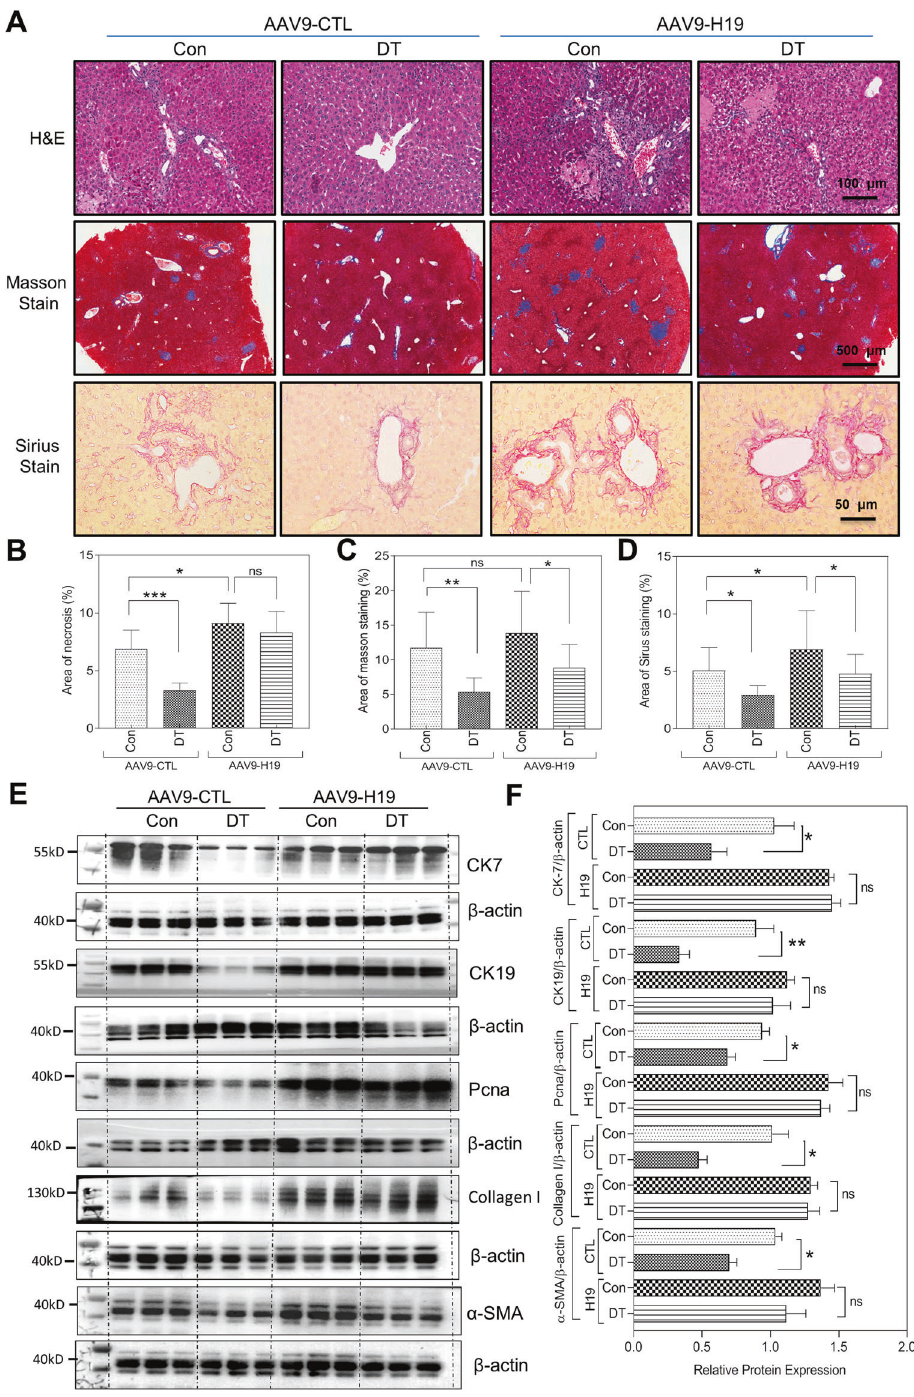
Fig. 5 H19 overexpression in the liver counteracts the macrophage depletion-mediated protective effect on cholestatic liver fi brosis and bile duct proliferation. A A dose of 1.0 × 10 11 vector genomes of the AAV9-H19 or controls (AAV9-CTL) were injected into CD11b-DTR mice via tail vein. After 1 week of injection, the mice were subjected to the BDL operation and randomly divided into four groups: AAV9-CTL, AAV9- H19, AAV9-CTL + DT, and AV9-H19 + DT (each group, n = 4 – 6). Representative images of H&E staining, scale bars: 100 μ m; Masson ’ s trichrome staining, scale bars: 500 μ m; and Sirius Red staining scale bars: 50 μ m for the livers sections from AAV9-CTL, AAV9-H19, AAV9-CTL + DT, and AV9-H19 + DT mice. B – D Quanti fi cation of necrosis area, Masson area, Sirius area in panel A. E Western blotting analysis for CK7, CK19, Pcna, Collagen I, α -SMA, and β -actin in livers of AAV9-CTL, AAV9-H19, AAV9-CTL + DT, and AAV9-H19 + DT mice. Representative images of the immune blottings are shown. F Quanti fi cation of panel E . Data were expressed as mean ± SD from four to six mice per group. * P < 0.05; ** P < 0.01, *** P < 0.001; ns, not signi fi